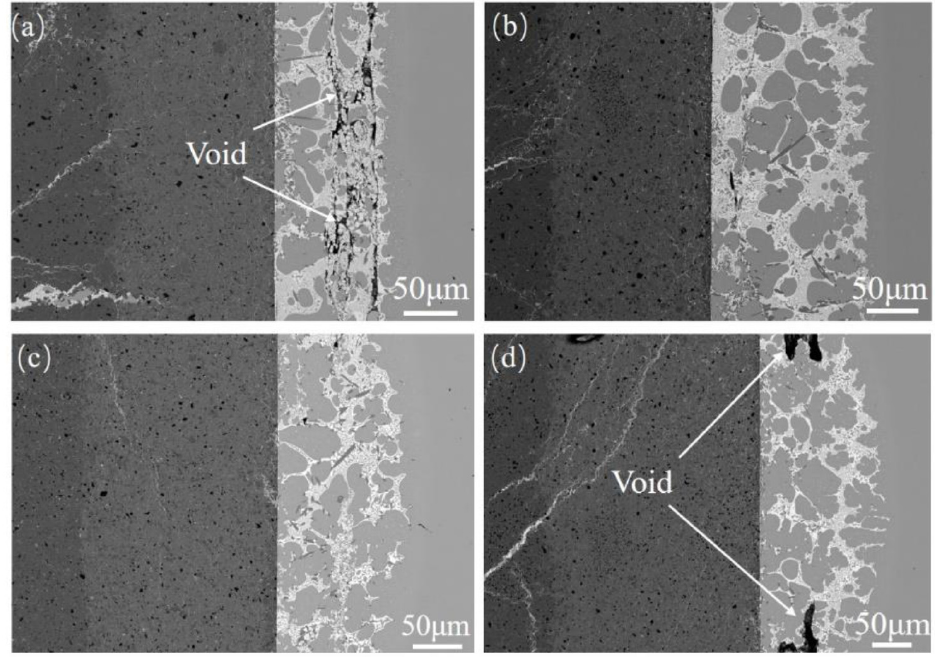
Figure 7. Effect of brazing temperature on interfacial microstructure of Ti 3 SiC 2 /Ag-Cu-Ti+Cu mesh/Cu joints: ( a ) T = 840 °C, ( b )T = 860 °C, ( c ) T = 880 °C, and ( d ) T = 900 °C.